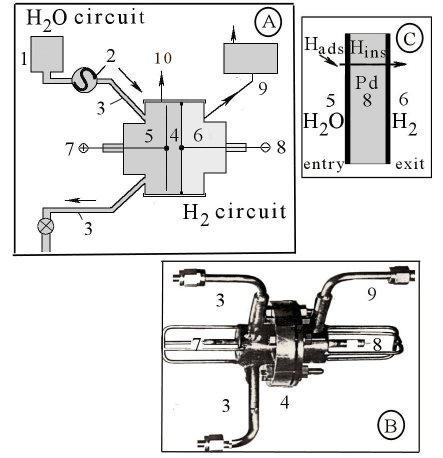
Figure 1. Electrolyzer for hydrogen production. ( A ): schematic of electrolyzer; ( B ): prototype elec- trolyzer; ( C ): schematic of Pd cathode membrane with hydrogen diffusion. 1: tank for water; 2: circulation pump; 3: water circulation piping; 4: electrolyzer; 5: water compartment; 6: hydro- gen compartment; 7: anode; 8: palladium cathode membrane; 9: hydrogen extraction; 10: oxygen extraction. ads: adsorption, ins: